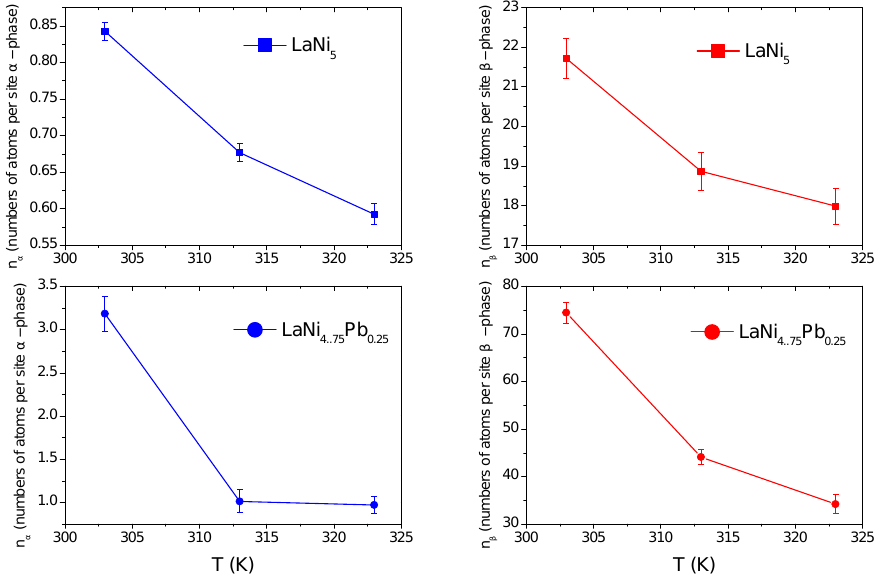
Figure 4. The temperature evolution of the number of H-atoms per receptor site n α , n β